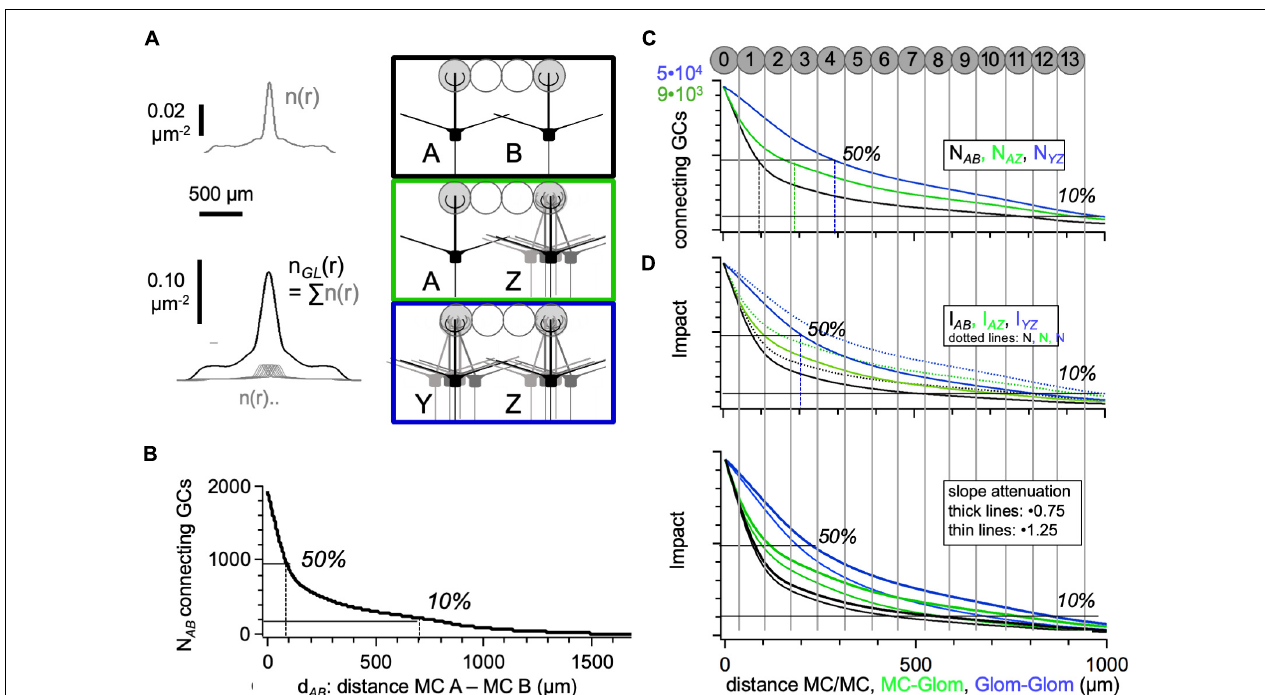
FIGURE 5 | Number of granule cells providing connectivity between two mitral cells or glomerular mitral cell ensemble. (A) Synaptic density distribution for single MC n(r) as in Figure 3B and for a glomerular ensemble of mitral cells n GL (r) (see Section “Materials and Methods”). (B) Number of GCs N AB that interconnects a pair of MCs versus their distance d AB (Eq. 9). The gray bars illustrate the average dimensions of glomeruli within the network (2 · r GL = 120 µ m). (C) Number of GCs that interconnect a pair of glomerular MC ensembles (blue line) or a single MC and an ensemble (green line), compared to the MC-MC case (black line). For better comparison, all three connectivity functions are scaled to the same size at d AB = 0, with the respective maximal numbers indicated in the respective color. (D) Top: Number of GCs as above but corrected for their functional impact. Dotted lines: Functions from above for comparison. Arbitrary units on the y-scale. Bottom: Impact with varying degrees of attenuation. The slope of the linear attenuation (fit in Figure 2C ) is increased or decreased by 25%. The spacing of glomeruli is indicated (diameter of glomeruli scaled to fit all 4000 glomeruli into A EPL , see Section